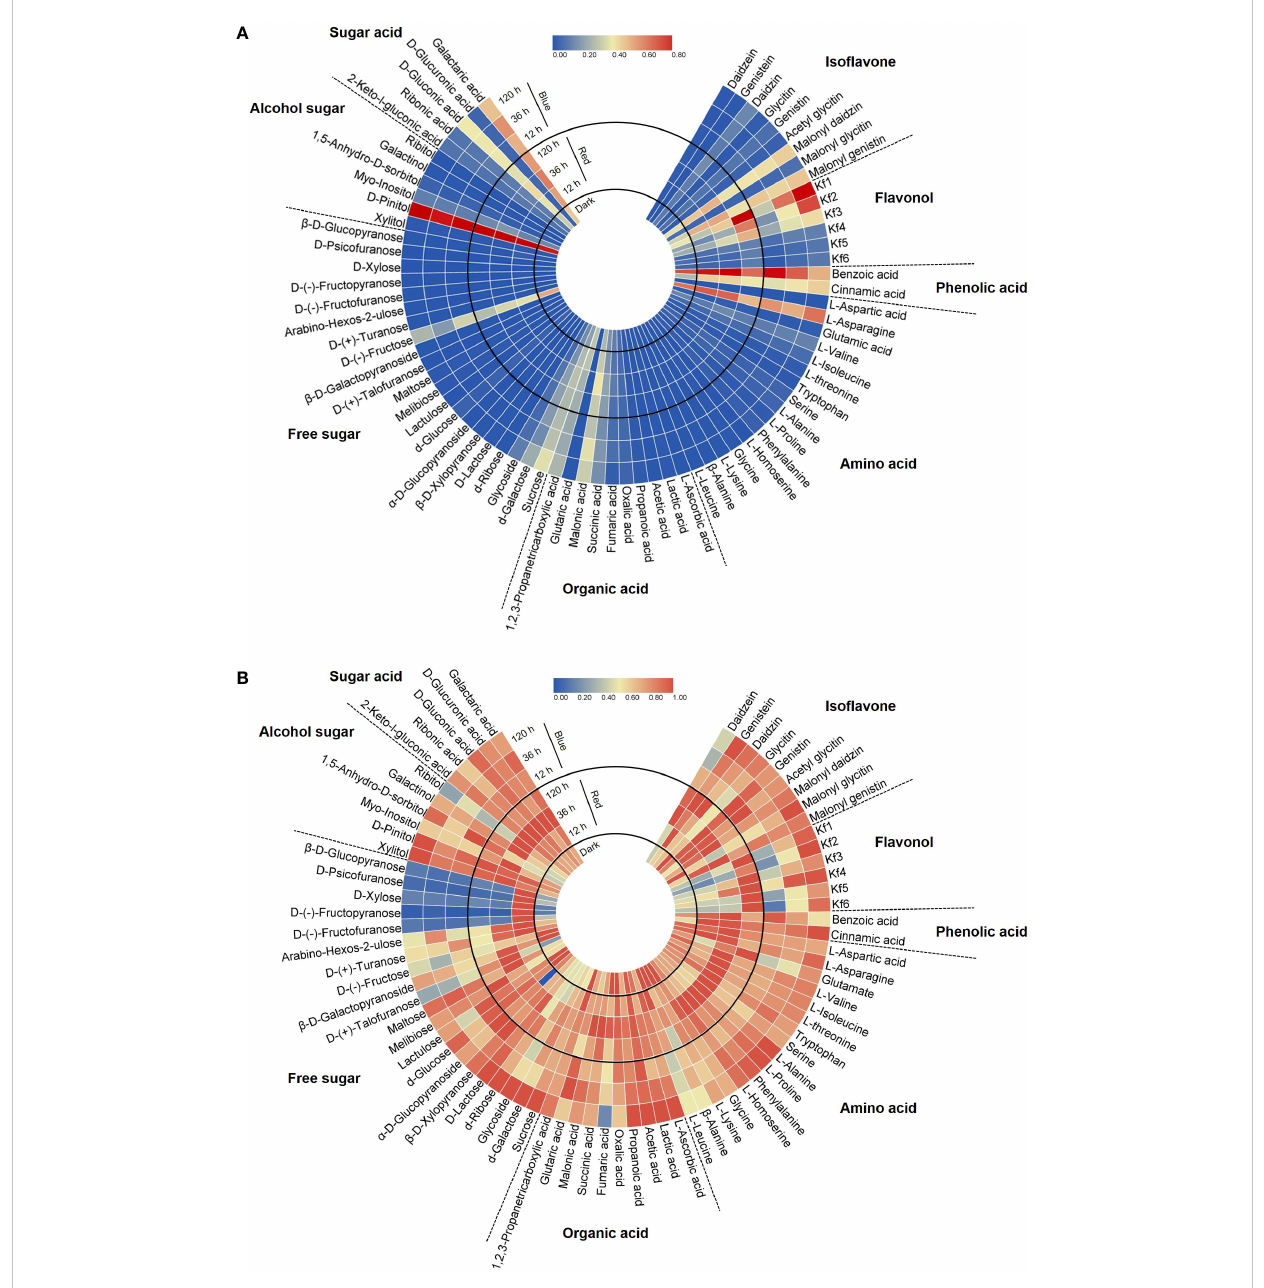
FIGURE 2 Circular heatmap based on the relative content in each category (A) and the relative content in each compound (B) . Metabolite data for the heatmap were normalized and plotted using Tbtools V1.098693. Kf1, kaempferol-3- O -glycosyl(1 ! 2)-rhamnosyl(1 ! 6)-galactoside; Kf2, kaempferol-3- O -(2,6- dirhamnosyl)-galactoside; Kf3, kaempferol-3- O -digalactoside; Kf4, kaempferol-3- O -diglucoside; Kf5, kaempferol-3- O -rhamnosyl-galactoside; Kf6, kaempferol-3- O